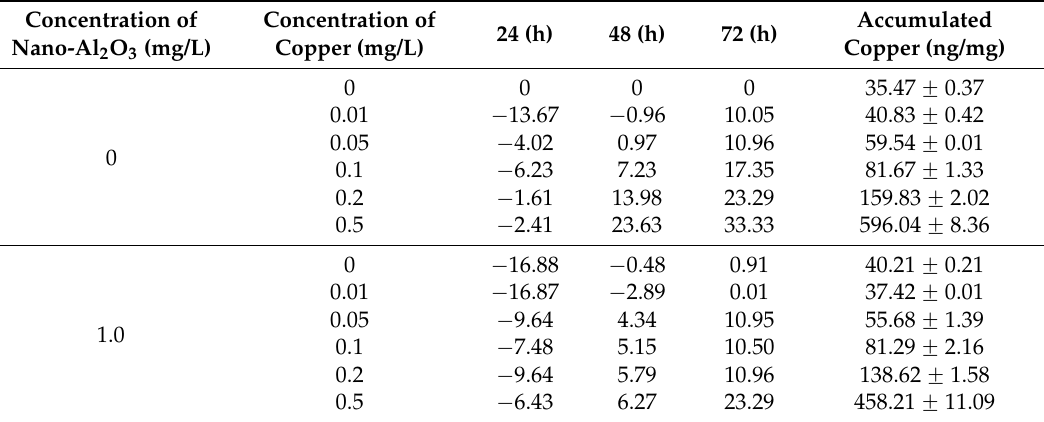
Table 4. Growth inhibition (%) during exposure and copper accumulation in S. obliquus exposed to copper and copper/nano-Al 2 O 3 systems after 72